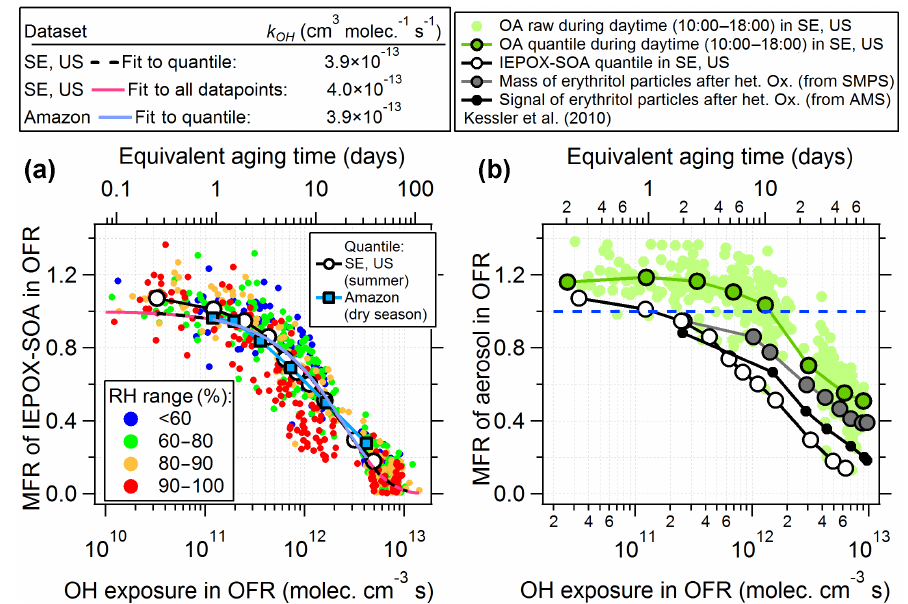
Figure 6. (a) Mass fraction remaining (MFR) of IEPOX-SOA in OFR output as a function of OH exposure during the entire SE US study and GoAmazon 2014/5 (dry season) studies. Individual datapoints from the SE US study are color-coded by ambient RH. Similar data for GoAmazon 2014/5 are shown in Fig. S21. (b) Mass fraction of OA remaining in OFR output as a function of OH exposure in daytime (12:00–18:00) during the SE US study. Also shown is the MFR of pure erythritol particles after heterogeneous oxidation as detected by SMPS and by AMS for reference (Kessler et al., 2010). Erythritol has a similar structure to the IEPOX-SOA tracers 2-methyltetrols.